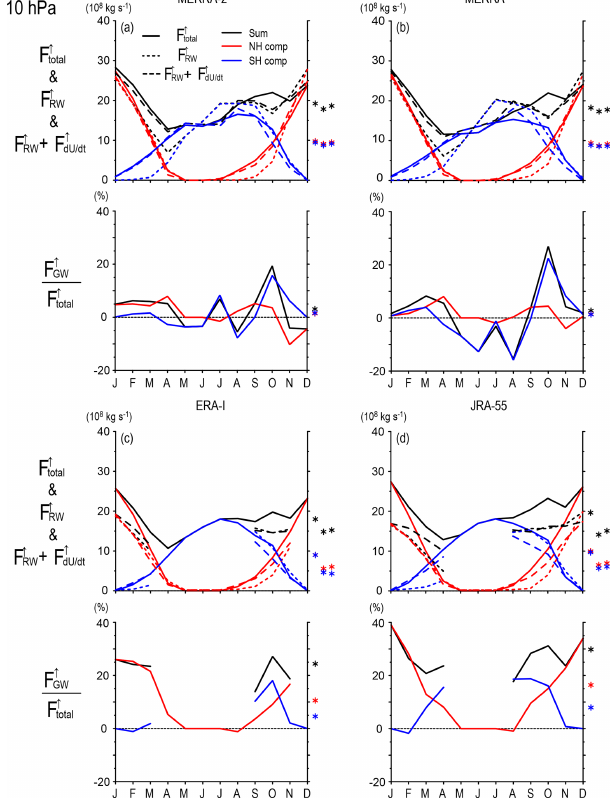
Figure 11. The same as Fig. 10 but for 10hPa.